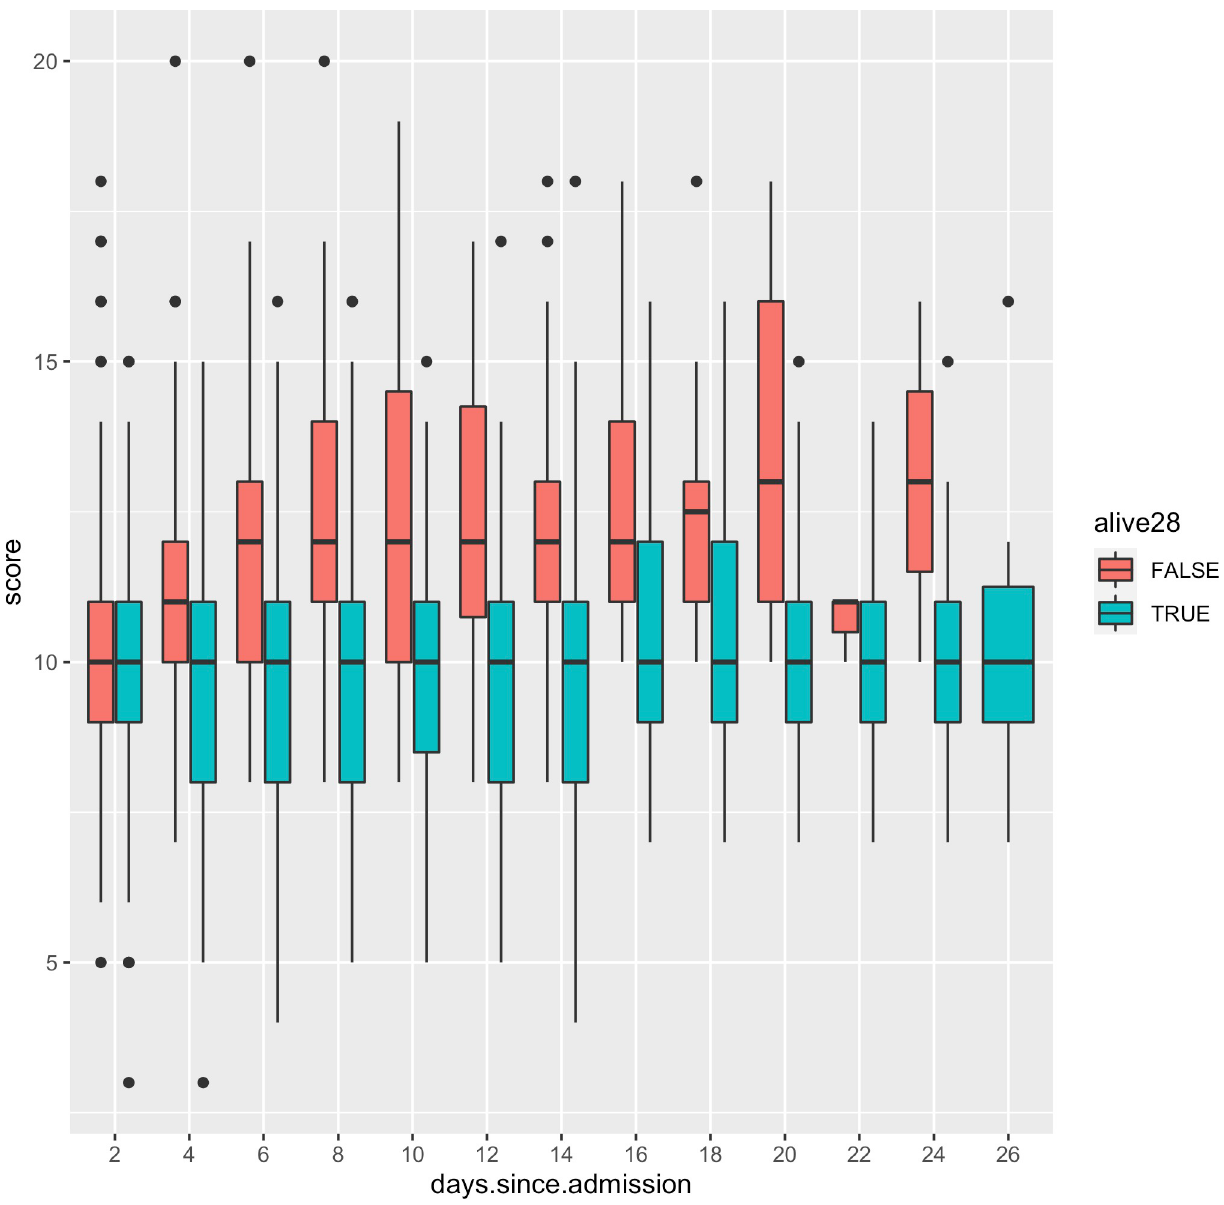
Fig 1. Boxplot distributions of 4CD in 48-hour intervals amongst survivors (turquoise) and decedents (red) in those still in hospital and who had a score of 10 at admission (high risk).